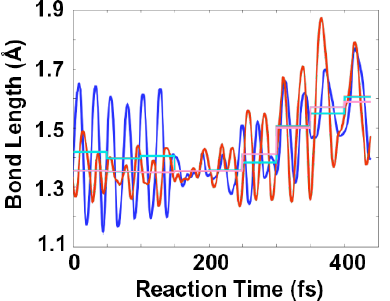
Figure 6. Time evolutions of bond lengths of C 1 =C 2 (blue curve) and C 5 =C 6 (red curve) in the trajectory with initial kinetic energy of 10 kcal/mol. Means in 50 fs periods are also indicated (light blue and pink lines,